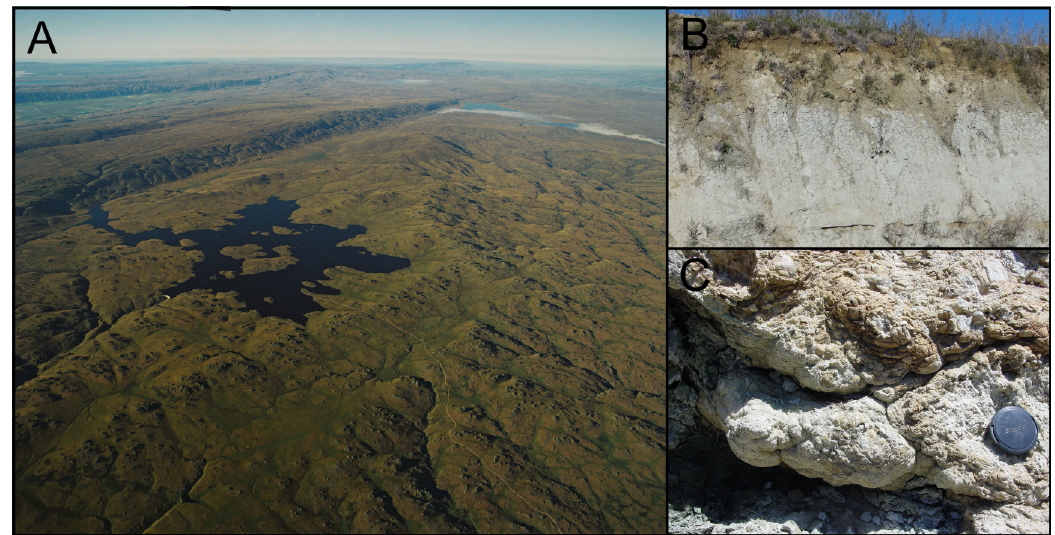
Figure 3. ( a ) Waipounamu Erosion Surface, Central Otago. The low-relief basement surface was cut by marine planation in the Cenozoic [12], and has been weakly deformed and uplifted during Plio-Pleistocene transpression which is still on-going. Pleistocene antiformal ranges in upper left are separated by synformal basins containing remnants of Miocene sediments, including sediments deposited in Lake Manuherikia. Photo: Lloyd Homer GNS Science. ( b ) Miocene lacustrine sediments (Lake Manuherikia) exposed in a three meter high roadcut in a synformal basin (top left, in ( a )). Tan-colored siltstone beds (top and bottom) are separated by a white clay-rich mudstone bed. ( c ) Fossil stromatolites that grew on the northern shore of Lake